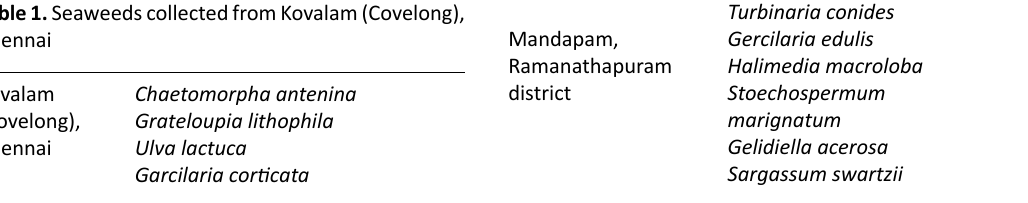
Table 1. Seaweeds collected from Kovalam